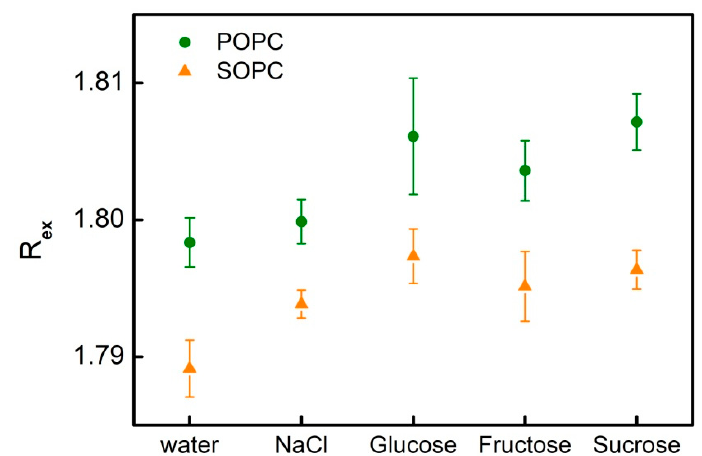
Figure 10. Di-8-ANEPPS fluorescence intensity ratio of POPC (circles) and SOPC (triangles) bilayers in 1 mmol/L NaCl sugar-free solutions and 200 mmol/L of glucose, fructose or sucrose; fluorescence excited at 420 and 520 nm and detected at 670 nm. Values are the mean of three independent experiments; the error bars correspond to the standard deviations.